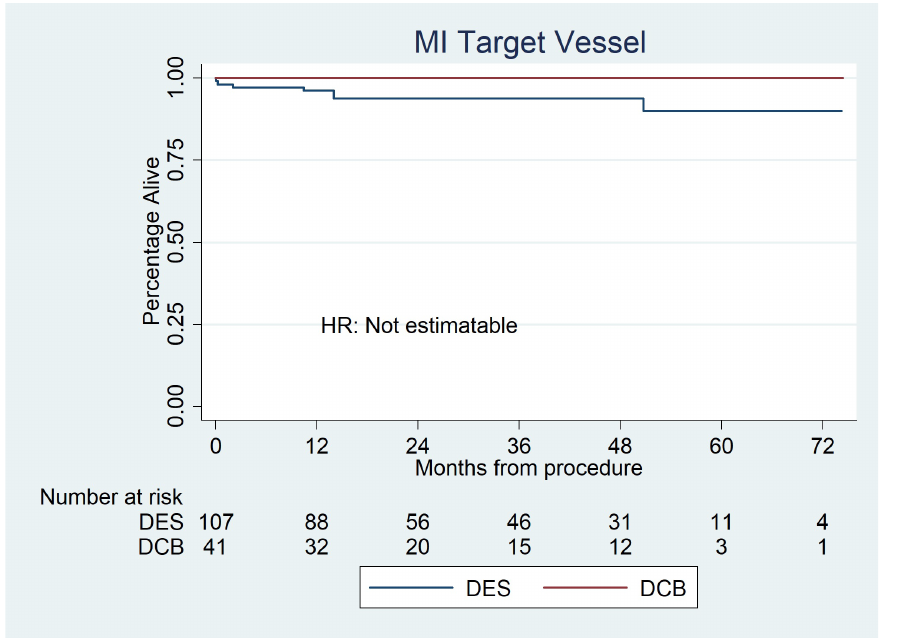
versus DESs, which shows no significant difference between the groups.